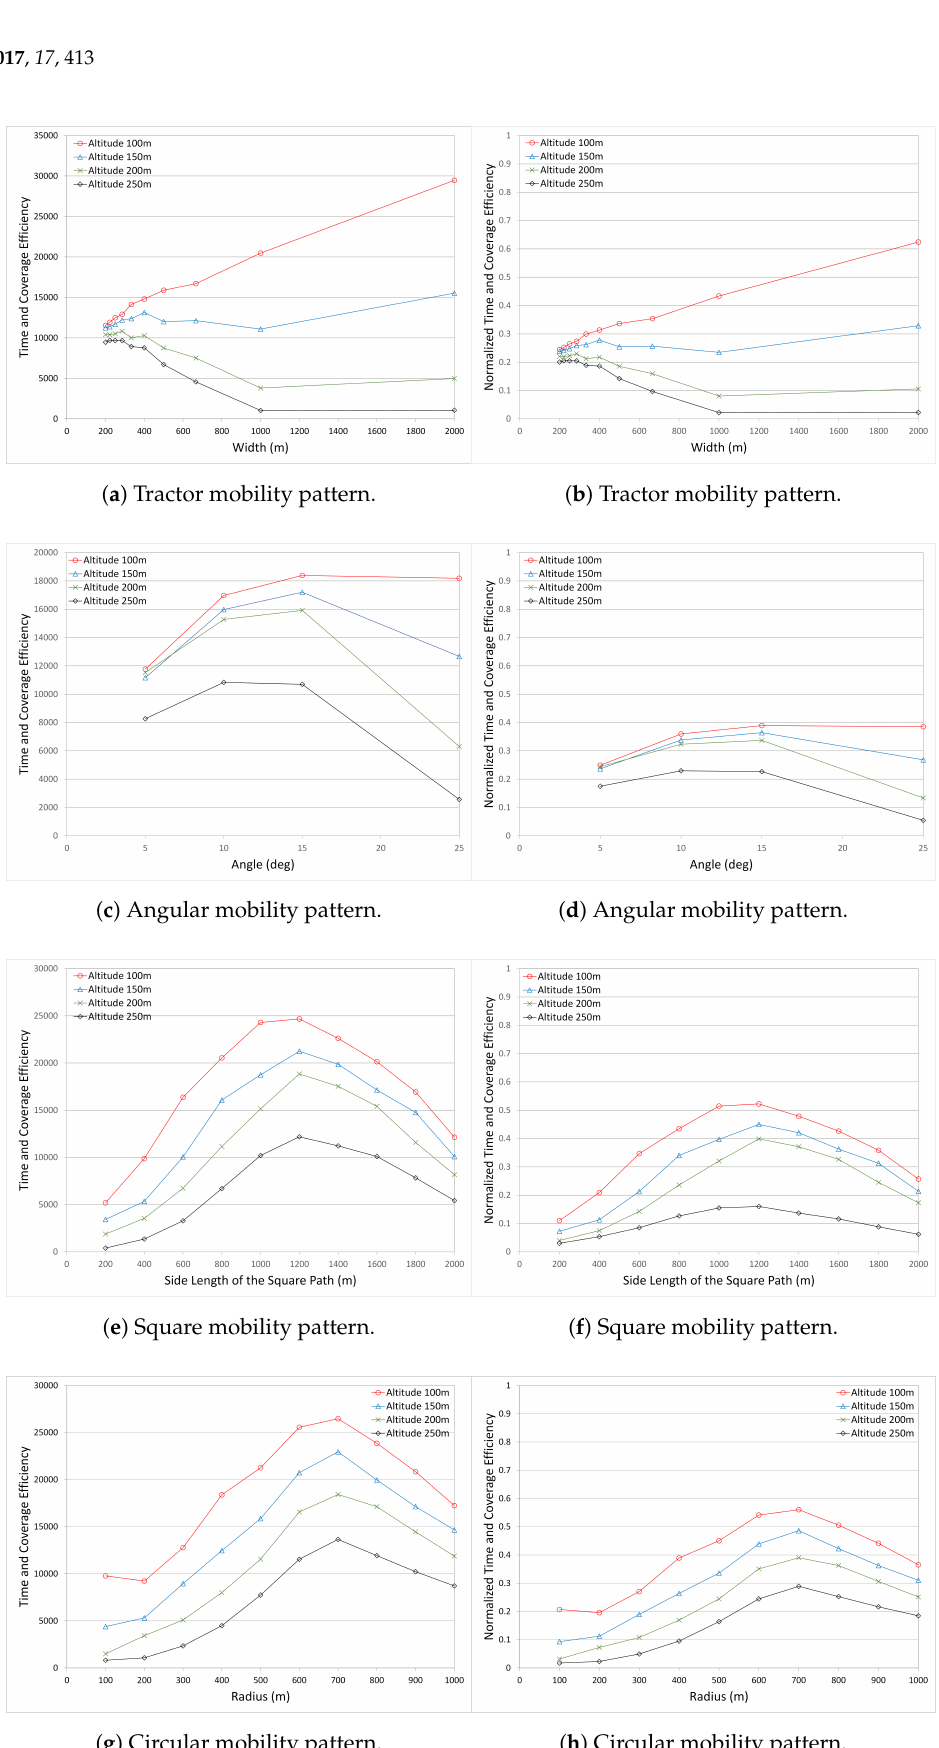
Figure 7. Comparison of Time versus Coverage Efficiency for all mobility